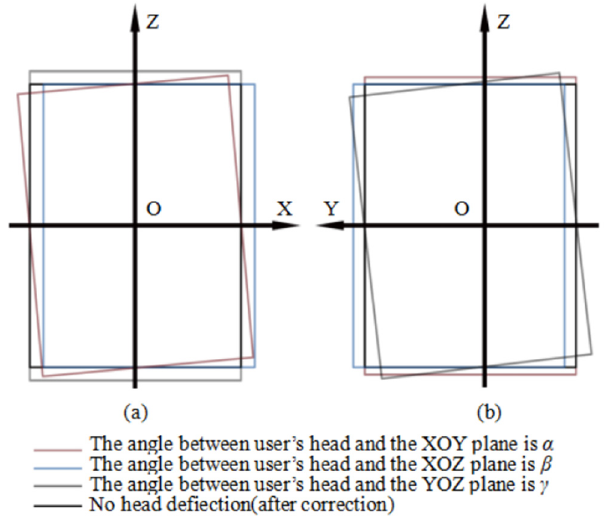
Fig. 14. Breakdown of two-dimensional de fl ection.